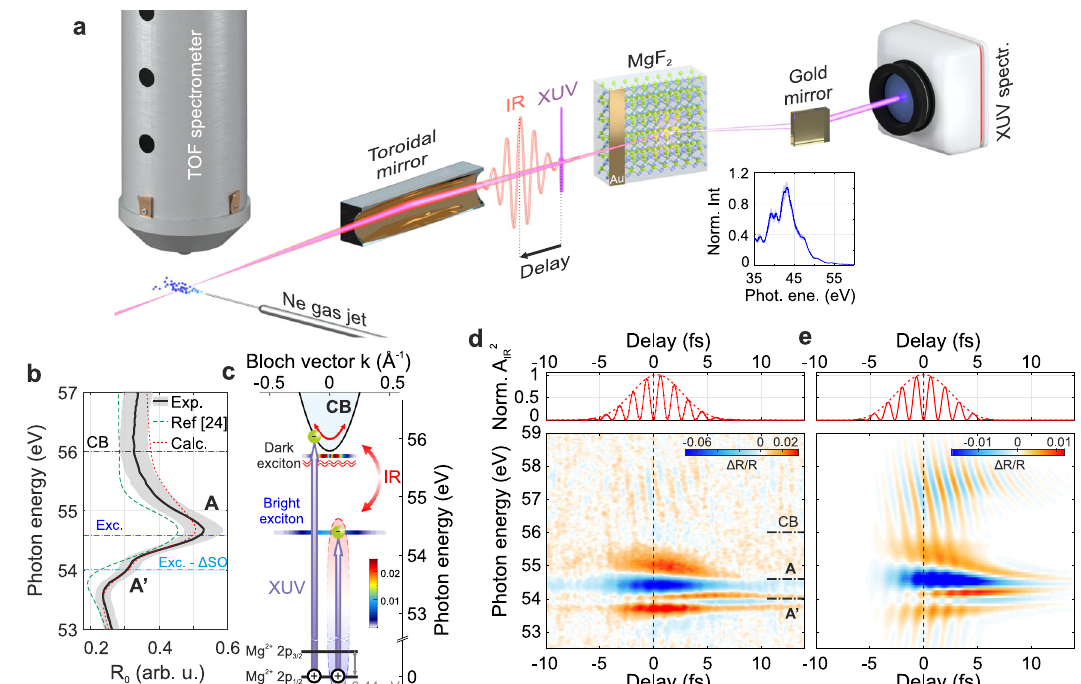
Fig. 1 MgF 2 core-exciton optical response. a Scheme of double-foci the experimental setup composed by the Ne gas target to perform an attosecond streaking experiment, the MgF 2 crystal and the XUV spectrometer. The inset shows the attosecond pulse spectrum as re fl ected by the MgF 2 sample. b Experimental (black solid) and calculated (red dotted) MgF 2 re fl ectivity for an incidence angle of 73.5°. The grey shaded area represents twice the standard deviation over repeated experimental measurements, while the green dashed curve is the re fl ectivity extracted from Hanson et al. 24 . The horizontal dash-dotted lines mark the vertical transitions from the Mg 2 + 2 p core level to the conduction band (CB) and the bright exciton 21 , accounting for the spin – orbit splitting of the Mg 2 + 2 p state. c MgF 2 band structure around its CB. While XUV photons can promote electrons from the Mg-2 p state directly into the CB, or to an electron – hole pair state (exciton), the IR fi eld perturbs the crystal, causing phenomena like intra-band motion or dressing of dark excitonic states. The false colours represent the density of states for the excitons. d Experimental and e calculated transient re fl ection spectrograms (main panels) as a function of the delay between the XUV and IR pulses, together with the square of the IR vector potential, A IR 2 , as extracted from the simultaneous streaking measurement (upper panels). The delay zero (vertical dashed line) has been chosen in order to coincide with a maximum of the IR electric fi eld squared. The experimental IR peak fl uence is 0.08 J/cm 2 .